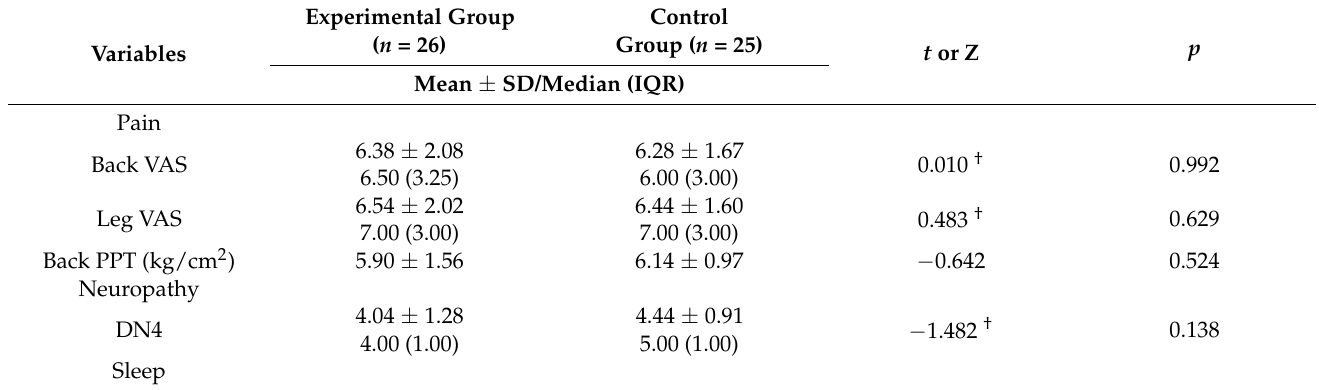
Table 2. Homogeneity of dependent variables between groups ( n =